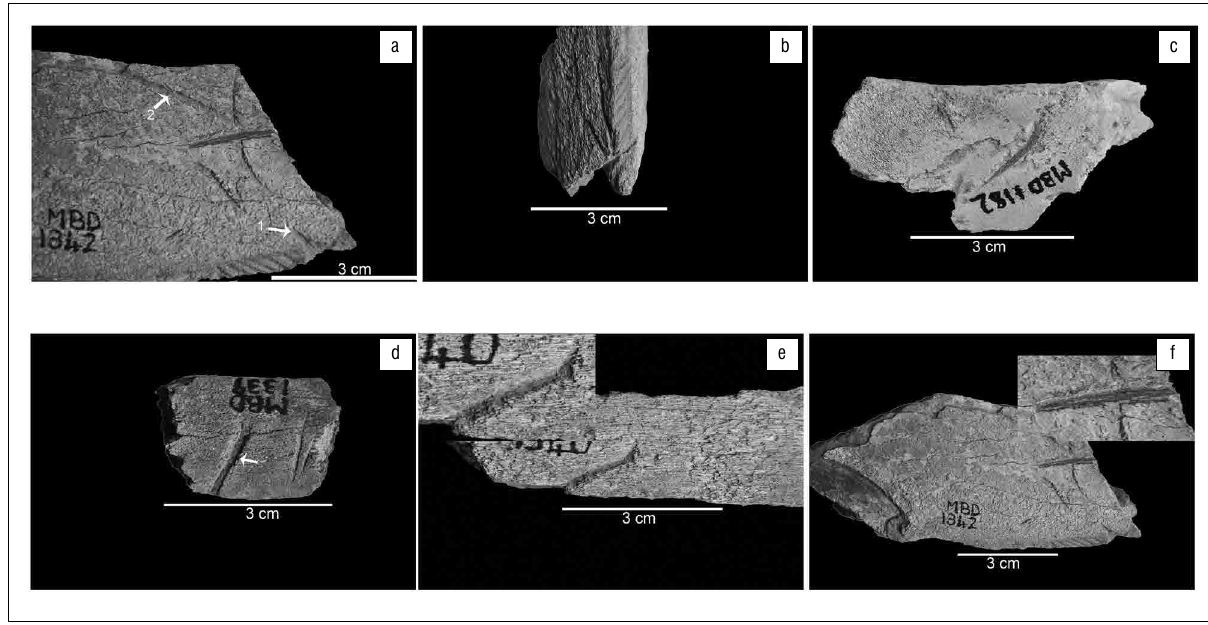
Figure 3: (a) CF2 bite marks on the lateral surface of cranial fragment (SAMPQMB-D-1342) (arrow 1, arrow 2). (b) CF2 bite mark on ventral surface of SAMPQMB-D-1342. (c) B1 bite mark on the lateral surface of a mandibular fragment (SAMPQMB-D-1182). (d) B2 bite mark on the small cranial fragment (SAMPQMB-D-1339) (arrow). (e) B2 bite mark on cranial fragment (SAMPQMB-D-1340) (inset close-up of damage). (f) B2 bite mark on the lateral surface of cranial fragment (SAMPQMB-D-1342) (inset close-up of damage).